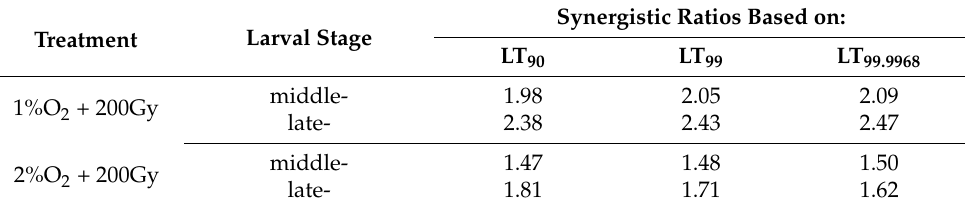
Table 4. Synergistic ratios for the middle- and late-stage larvae of T. granarium treated at 24–26 °C.